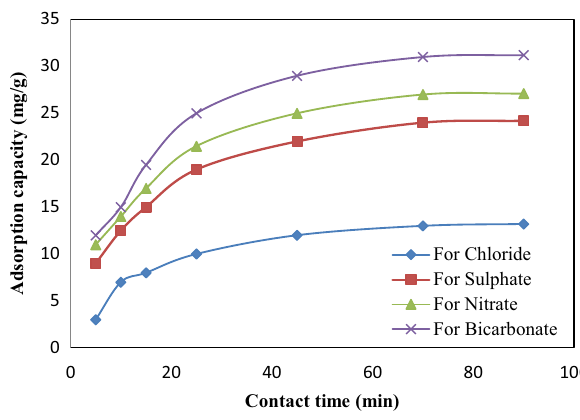
Langmuir and Freundlich isotherms for MR sorption onto